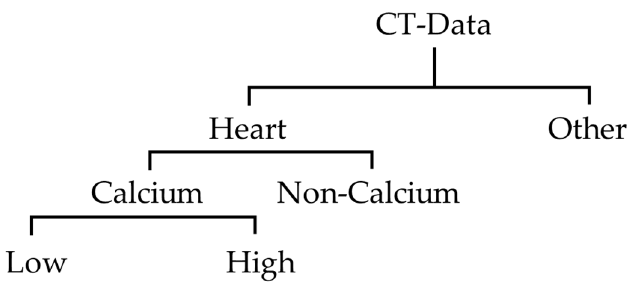
Figure 4. Cardiovascular CT image labeling structure proposed in this paper.